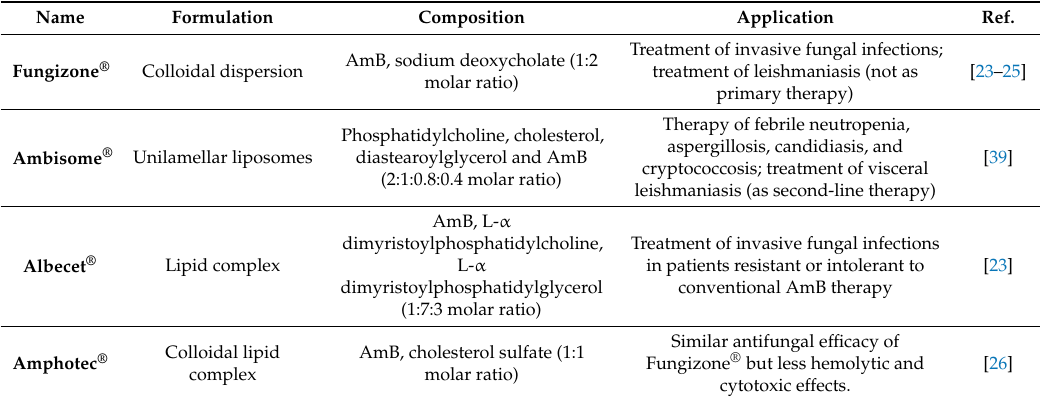
Table 1. Main features of AmB